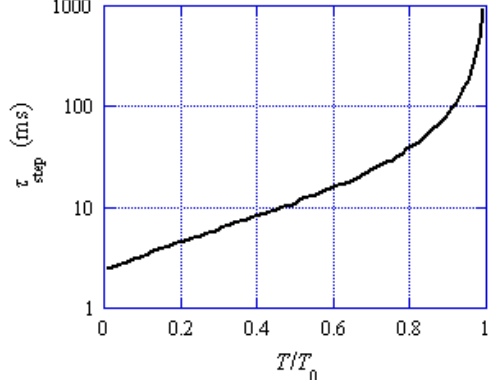
for a step motion of the myosin head as a function of T / T Figure 5. Time interval  step = L / v , which is approximately equal to the time interval of the occurrence of the  step U *